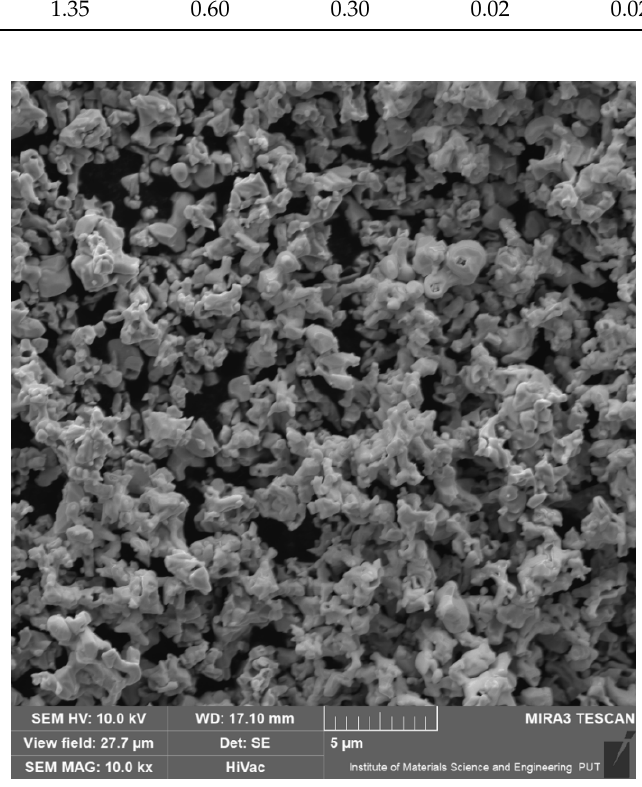
Figure 1. Morphology of tantalum carbide powder (APS < 6 µm).